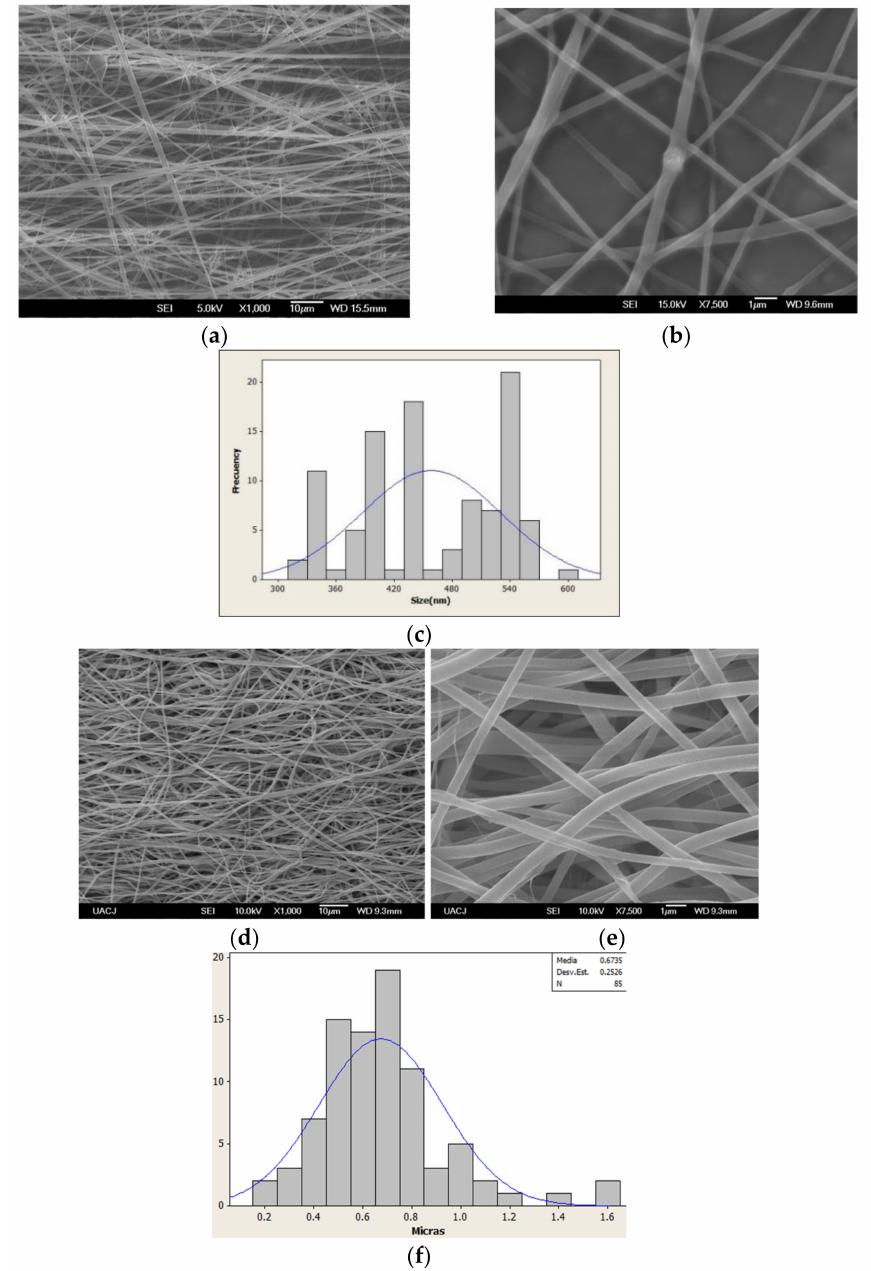
Figure 4. Aminated nanofibers without EGF: ( a ) 1000 × ( b ) 7500 × ( c ) nanofiber diameter distribution; with EGF: ( d ) 1000 × ( e ) 7500 × ( f ) nanofiber diameter